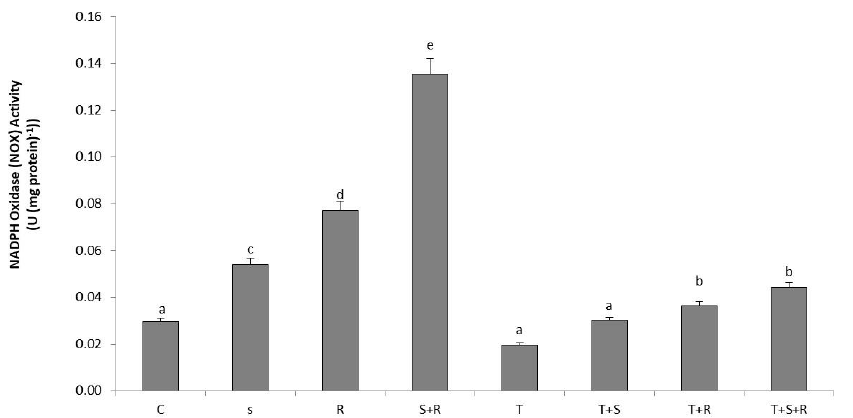
Figure 7. The effect of T. citrinoviride on NOX activity in the leaves of strawberry plants which were subjected to abiotic stress (40 mM NaCl) and biotic stress (R. solani) either separately or in combination. Different letters indicates significant differences between treatments ( p < 0.05). C, control; S, NaCl-treated; R, R. solani -infected ; S + R, Salt stress + R. solani; T, T. citrinoviride- treated; T + S, T. citrinoviride + NaCl; T + R, T. citrinoviride + R. solani ; T + S + R, T. citrinoviride + NaCl + R. solani.